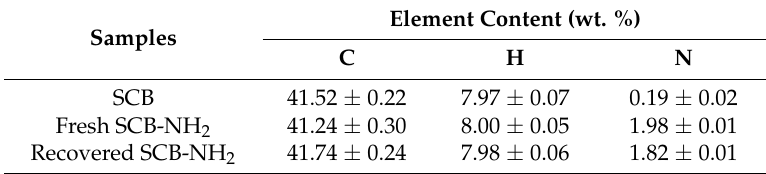
Table 1. The element analysis of SCB, fresh SCB-NH 2 , and recovered SCB-NH 2 .